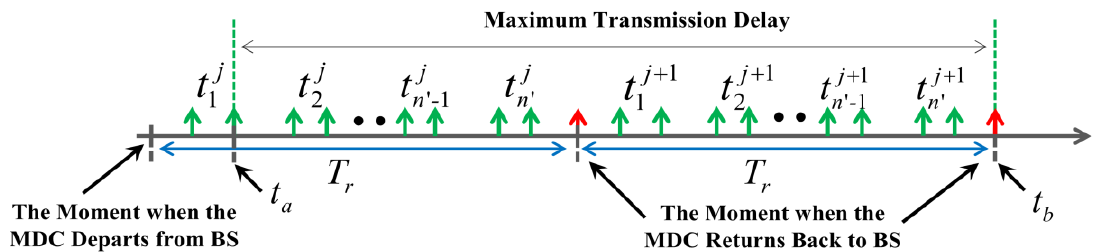
Figure 11. Maximum delay on data packet transmission.